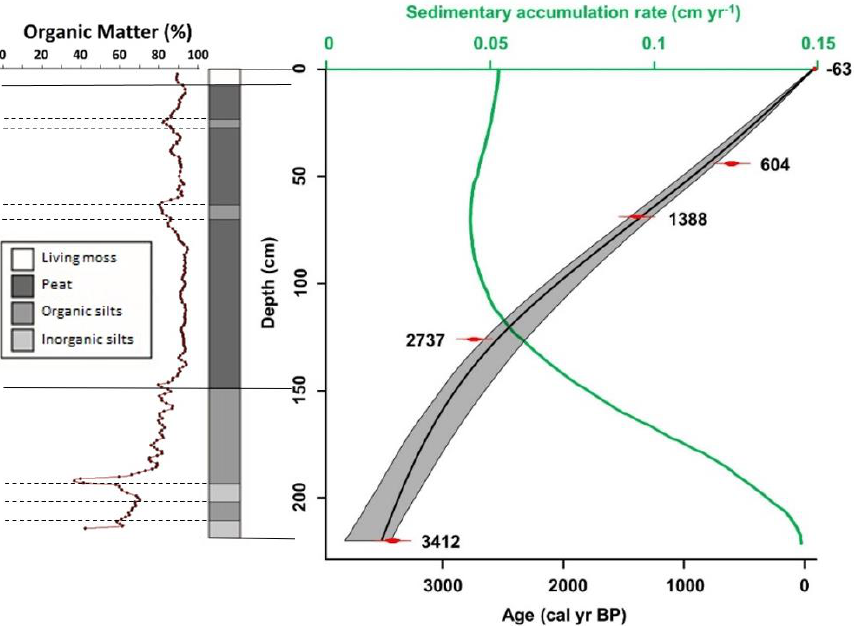
Figure 4. Dates, smoothed age-depth chronological model, sedimentary description, organic matter, and sedimentary accumulation rate of the Clots de Rialba record (CdR1).